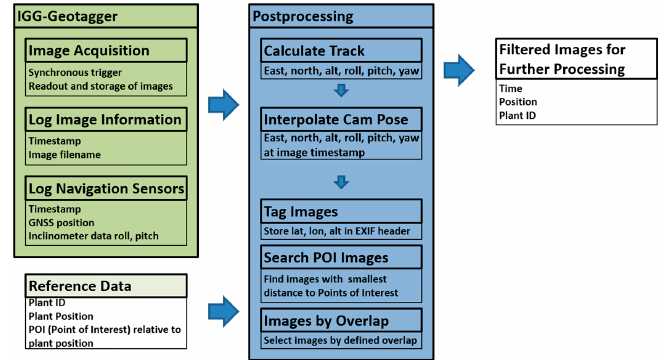
Figure 2. Tasks within IGG (Institute of Geodesy and Geoinformation) Geotagger 2.0. GNSS: Global Navigation Satellite System; Plant ID: Plant identification; EXIF: Exchangeable image file format.